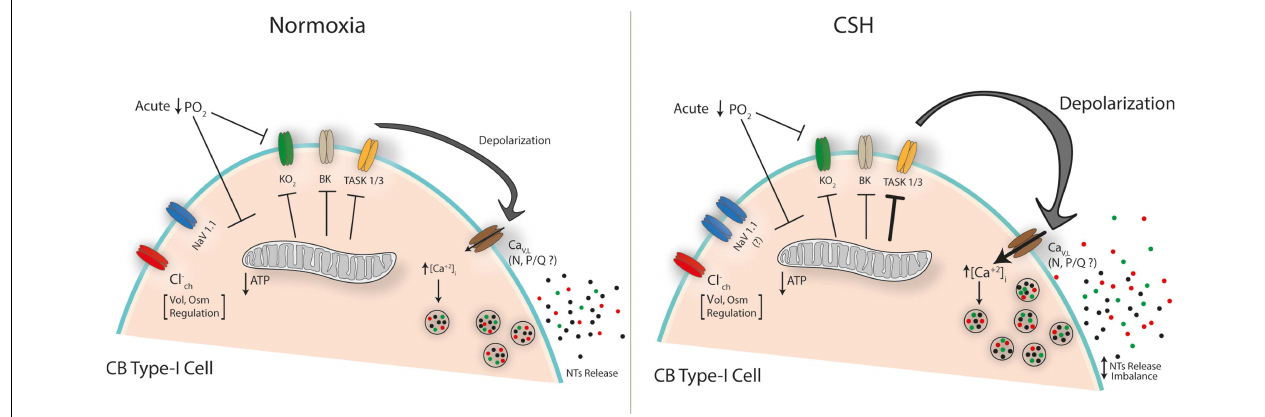
FIGURE 1 | Proposed mechanisms of CB type-I cell hyperexcitability under chronic sustained hypoxia (CSH). The scheme depicts the main ion channels described in CB type-I cells. Acute fall in the PO 2 inhibits K + conductance(s) either directly on membrane components (i.e., KO 2 ) or indirectly by reducing mitochondrial ATP production (‘metabolic hypothesis’) triggering a membrane depolarization that leads to the calcium-dependent neurotransmitters (NTs) release, initiating the chemosensory response to hypoxia. Under CSH an increased Na-current has been suggested [Nav1.1 subunit increased expression (Cáceres et al., 2007)] while a potentiated inhibition of a TASK-like K + − channel activity which induced a larger depolarization has been described (Ortiz et al., 2007, 2013). A major voltage-dependent calcium entry (mainly through L-type Ca-channels) is expected, which could explain the CB neurotransmitter release imbalance under CSH. Chloride channel(s) have been related with volume (Vol) and osmolarity (Osm) regulation but they would not participate in CSH